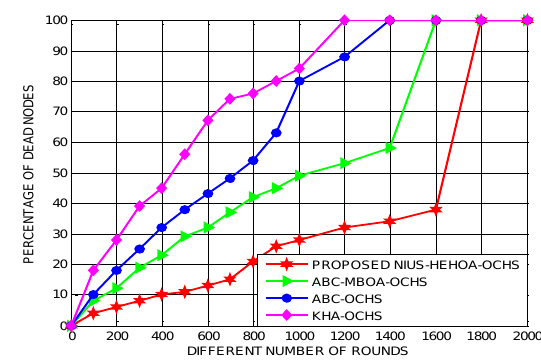
Figure 2 . Proposed NIUS-HEHOA-OCHS: Percentage of Dead nodes under different rounds